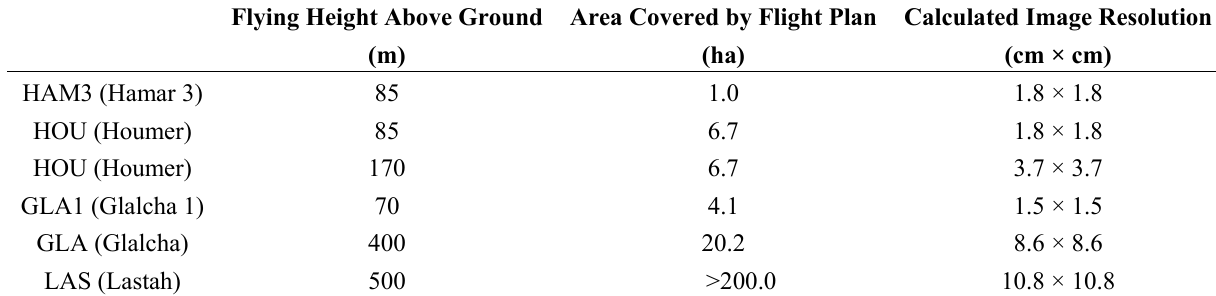
Table 1. Selected parameters for image acquisition survey on selected study sites. Values are taken from MAVinci software since, e.g., setting the parameter flying height defines the area covered by the resulting flight